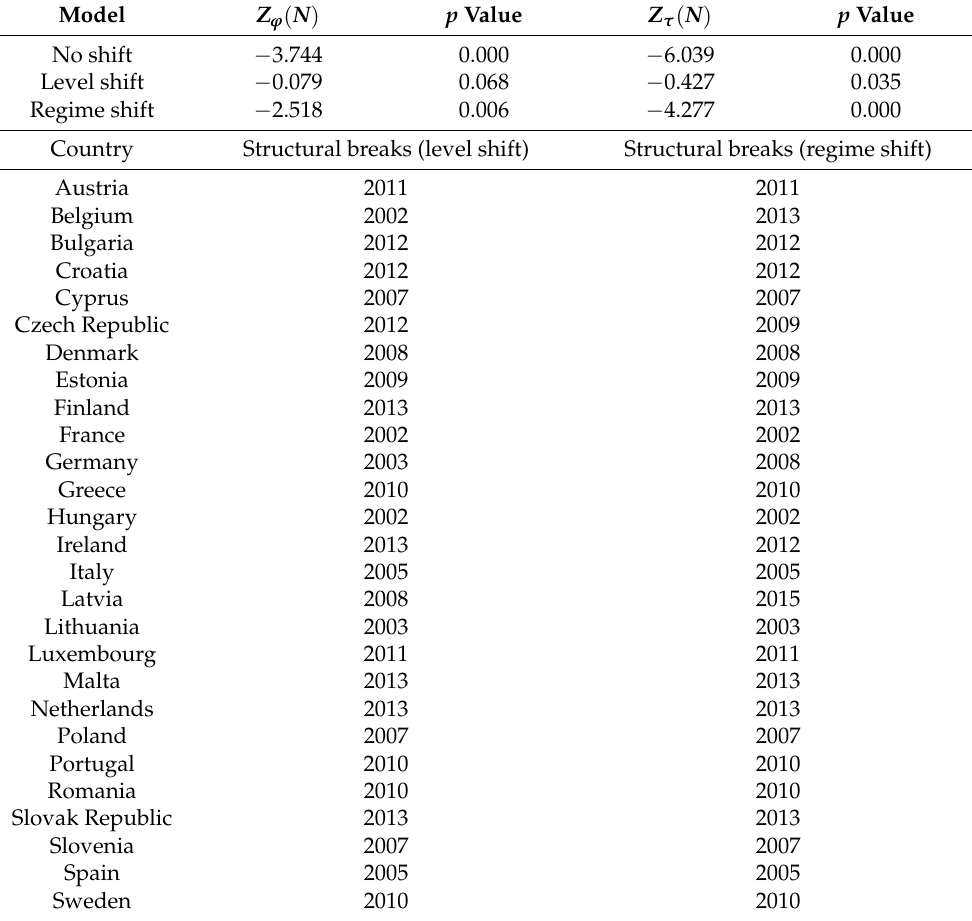
Table 5. Results of Westerlund and Edgerton Cointegration Test